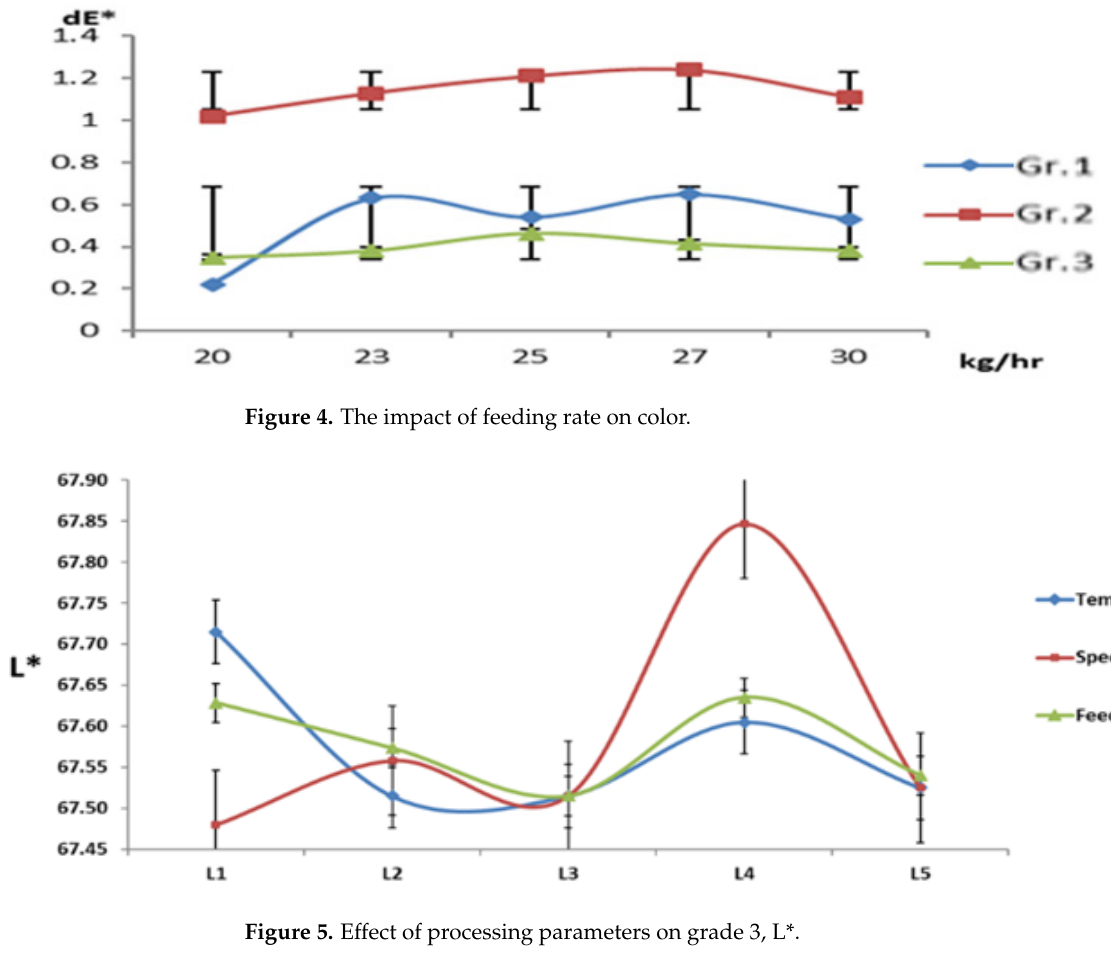
Figure 6. Interaction effect of Grade 1, Grade 2 and Grade 3. Figure 7. Effect of feed rate on dE* for Grade 1, Grade 2 and Grade 3.